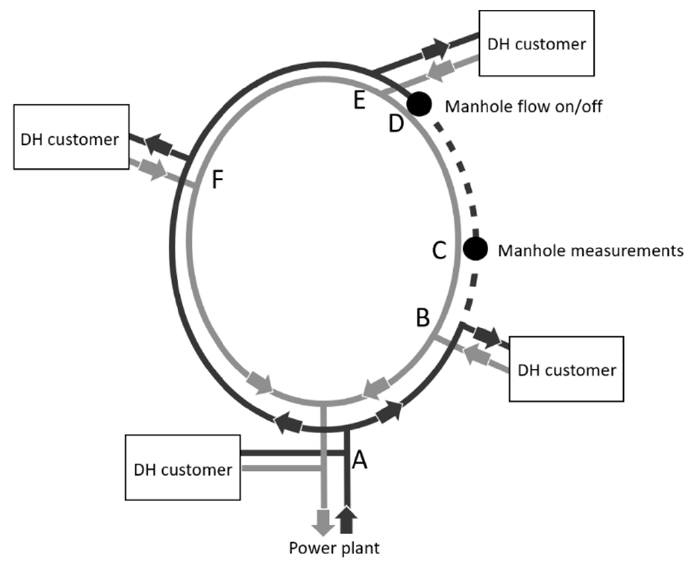
Figure 1. Pipe network and measurement location. ( C ) measurement point for analyses (i.e., valves). ( D ) supply flow shutdown point. Ordinary flow direction is ( A – E ). During shutdown at valve point ( D ), the flow between ( B , D ) (dashed line) stops and new flow towards ( E ) is only via ( F ). Supply water is shown in black and return water in grey.